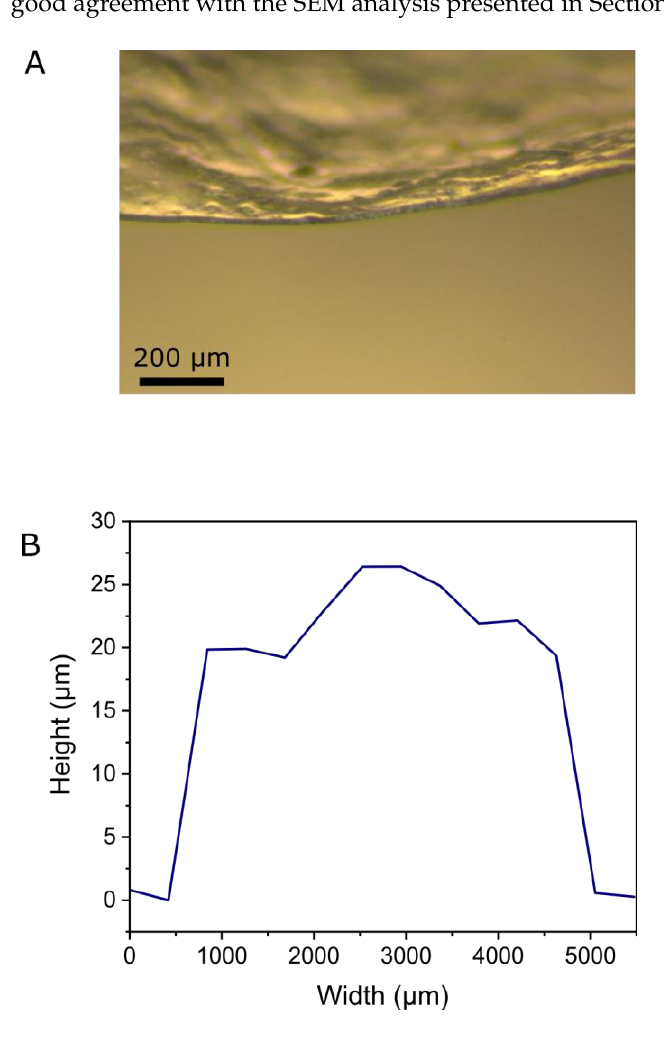
Figure 7. ( A ) Optical micrograph of the edge of an HPMC – CS film. ( B ) Height profile of a section of HPMC – CS film.